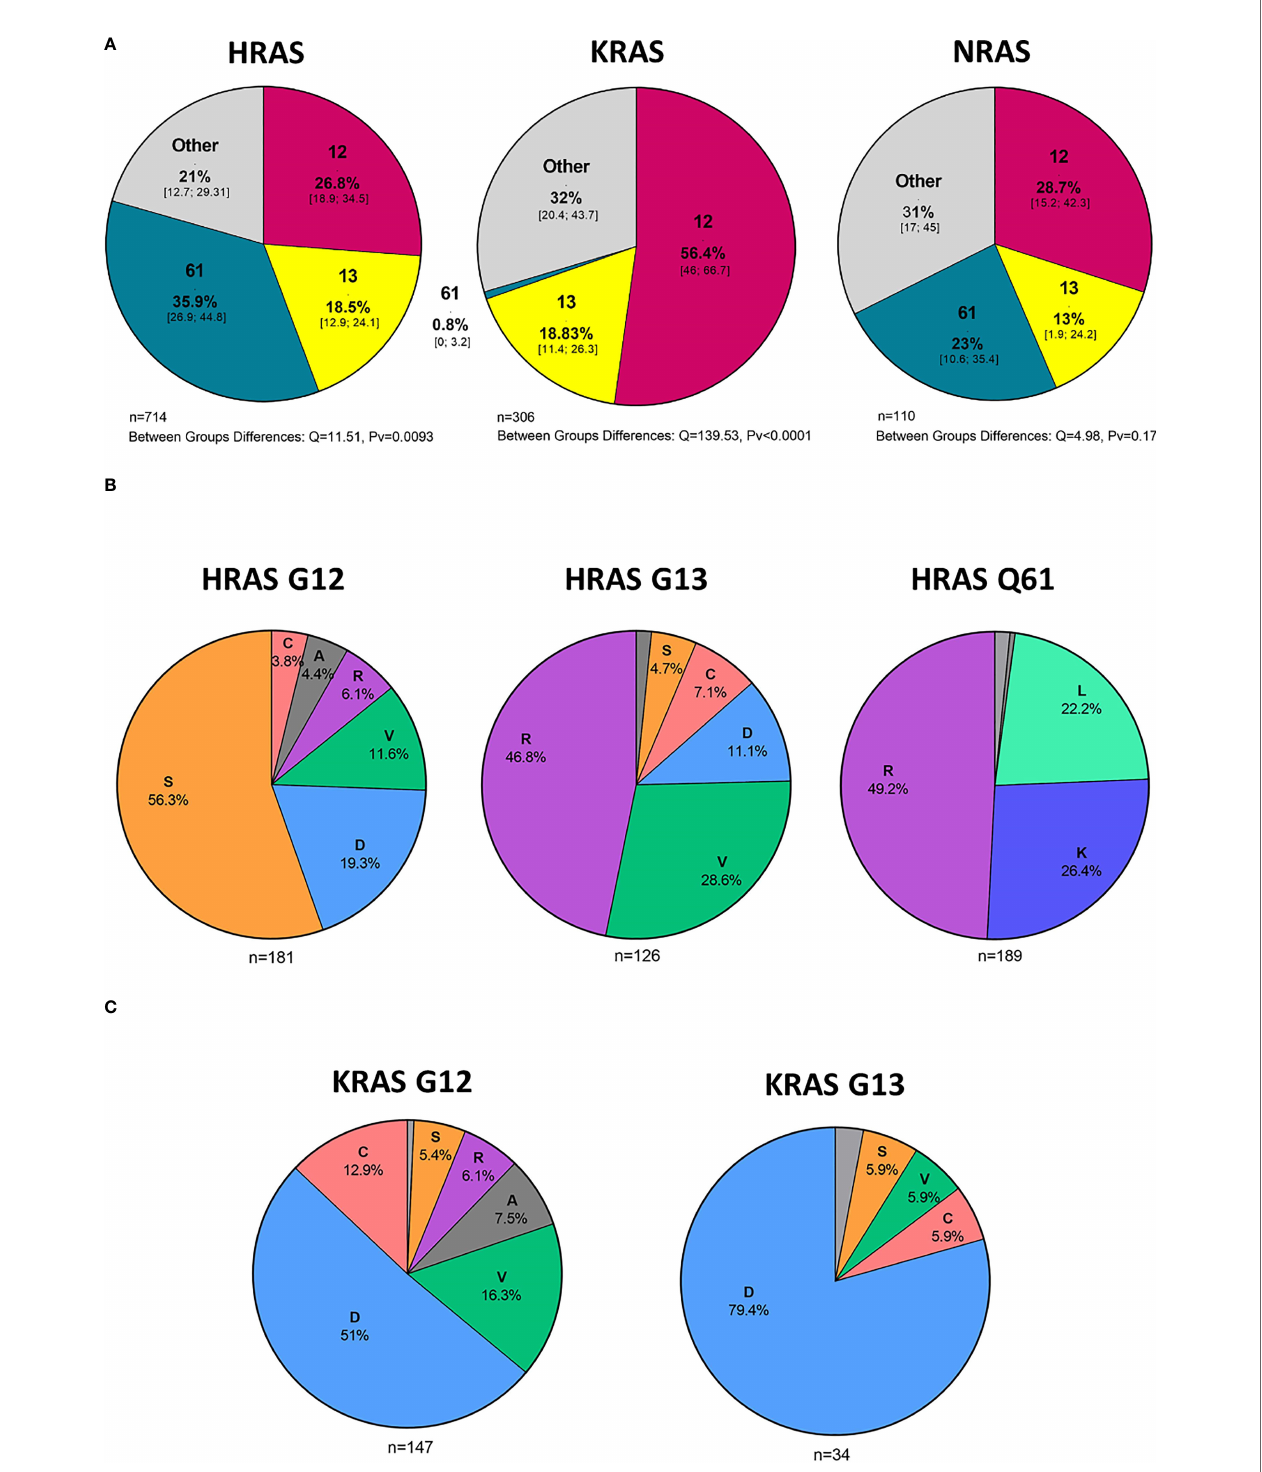
FIGURE 4 | Hot spot mutations and amino acid substitutions. (A) Mutated codons [%] in cases with HRAS, KRAS, and NRAS mutations and 95% CI. (B) Amino acid substitutions [%] in cases with KRAS G12 and G13 mutations. (C) Amino acid substitutions [%] in cases with HRAS G12, G13, and Q61 mutations. D - aspartic acid, C, cysteine; V, valine; S, serine; R, arginine; A, alanine; K, lysine; L, leucine; CI, Con fi dence